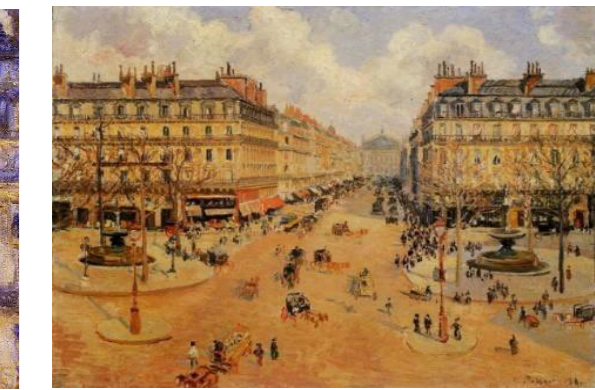
Fig. 10 Rue Halévy, vue d'un sixième étage 1878 oil on canvas 60 × 73 cm